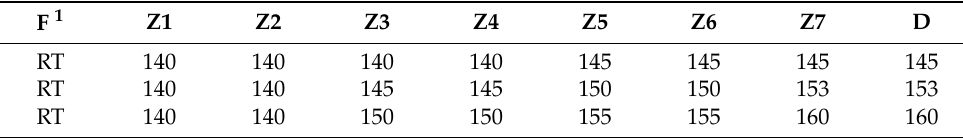
Table 3. Extrusion temperature profiles controlling nine temperature zones: seven extruder barrel zones (Z), one die temperature (D), and one feeder temperature